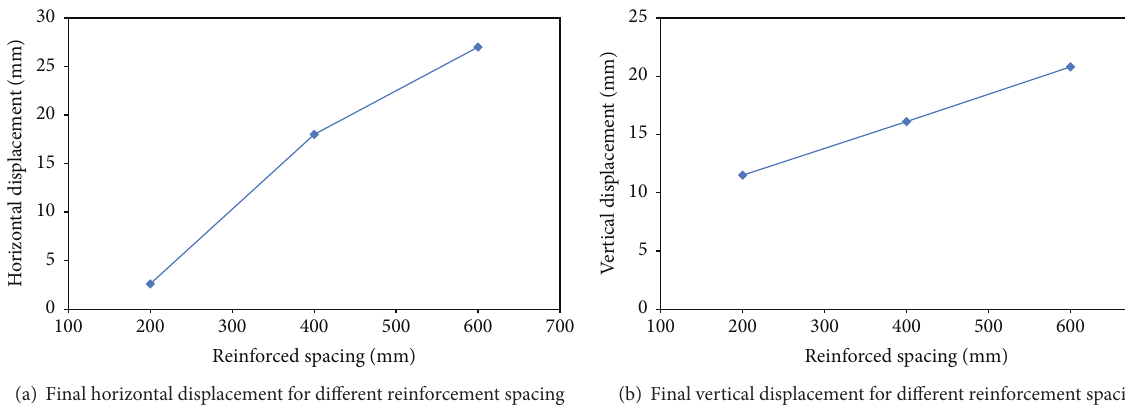
Figure 9: Final block displacement as a function of reinforcement spacing.